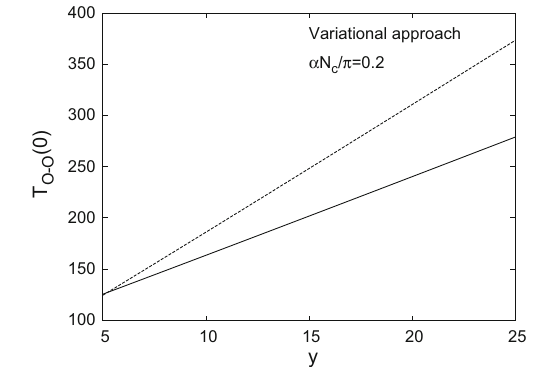
Fig. 10 Eikonal T ( 0 ) for central O–O collisions obtained by the vari- ational approach, with the quadruple pomeron interaction S 4 (lower curve) and without it (upper curve)